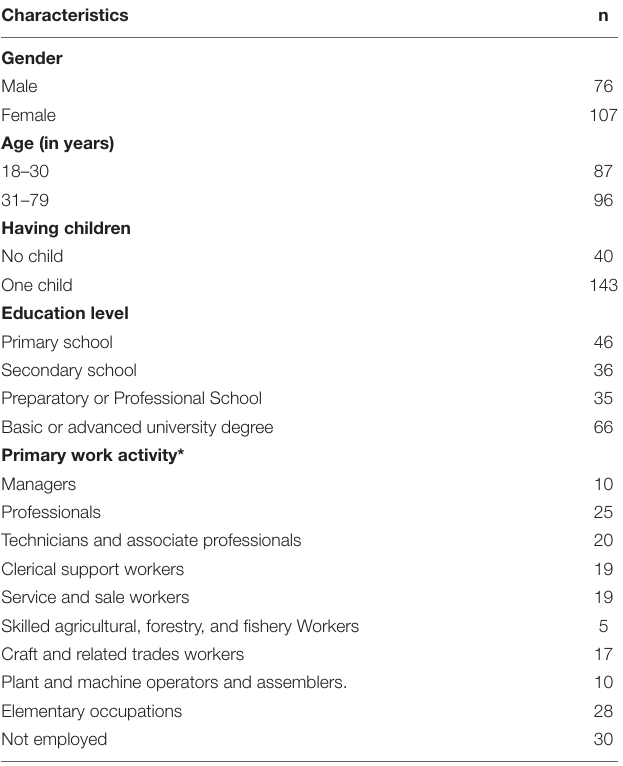
TABLE 1 | Sample characteristics ( n =